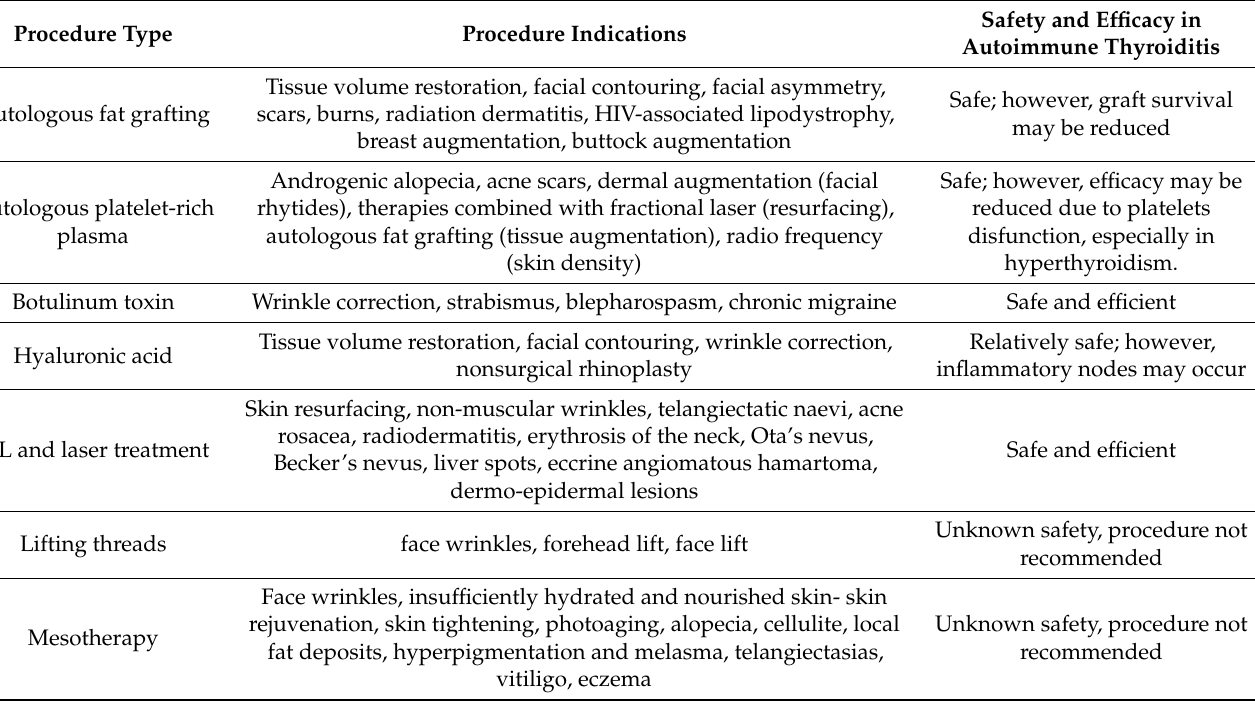
Table 1. Effectiveness and safety of aesthetic medicine procedures in patients with autoimmune diseases of the thyroid